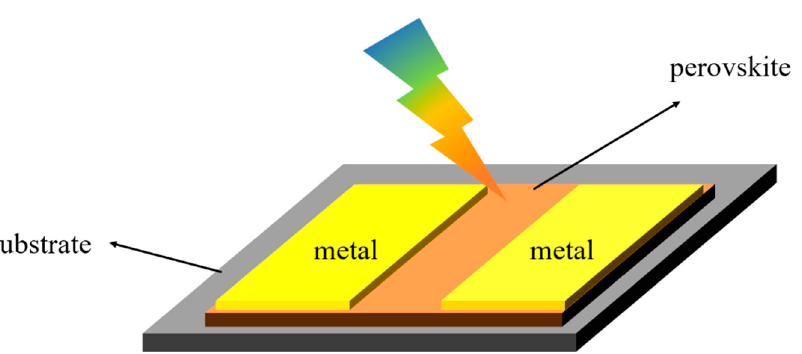
Figure 2. Structure diagram of the perovskite photoconductor.